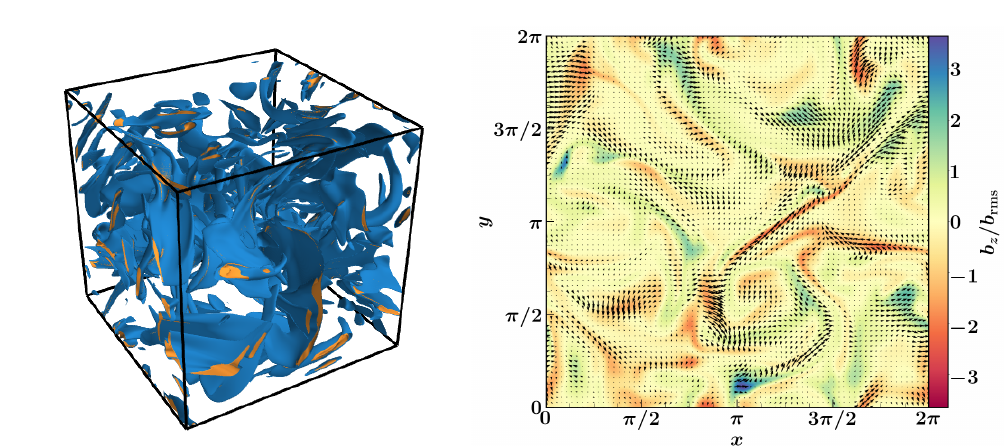
Figure 4. Left panel: Isosurfaces of b 2 / b 2 rms = 3 (blue) and 4 (yellow) of the magnetic field obtained from a small-scale dynamo simulation. It is intermittent with the field concentrated in filaments and sheets. Right panel: A 2D cut in the xy-plane through the numerical box with vectors for ( b x / b rms , b y / b rms ) and colour showing b z / b rms for the field. The figure shows strong fields in elongated structures.